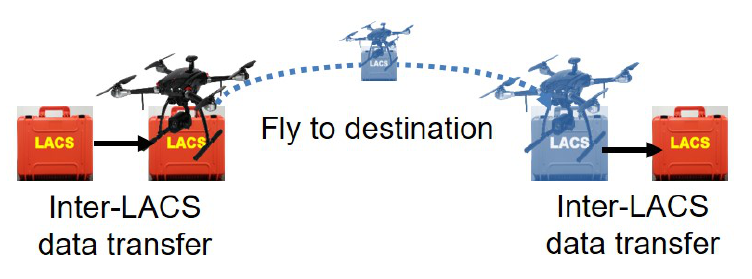
Figure 7. The message ferry as a link in the LACS network.